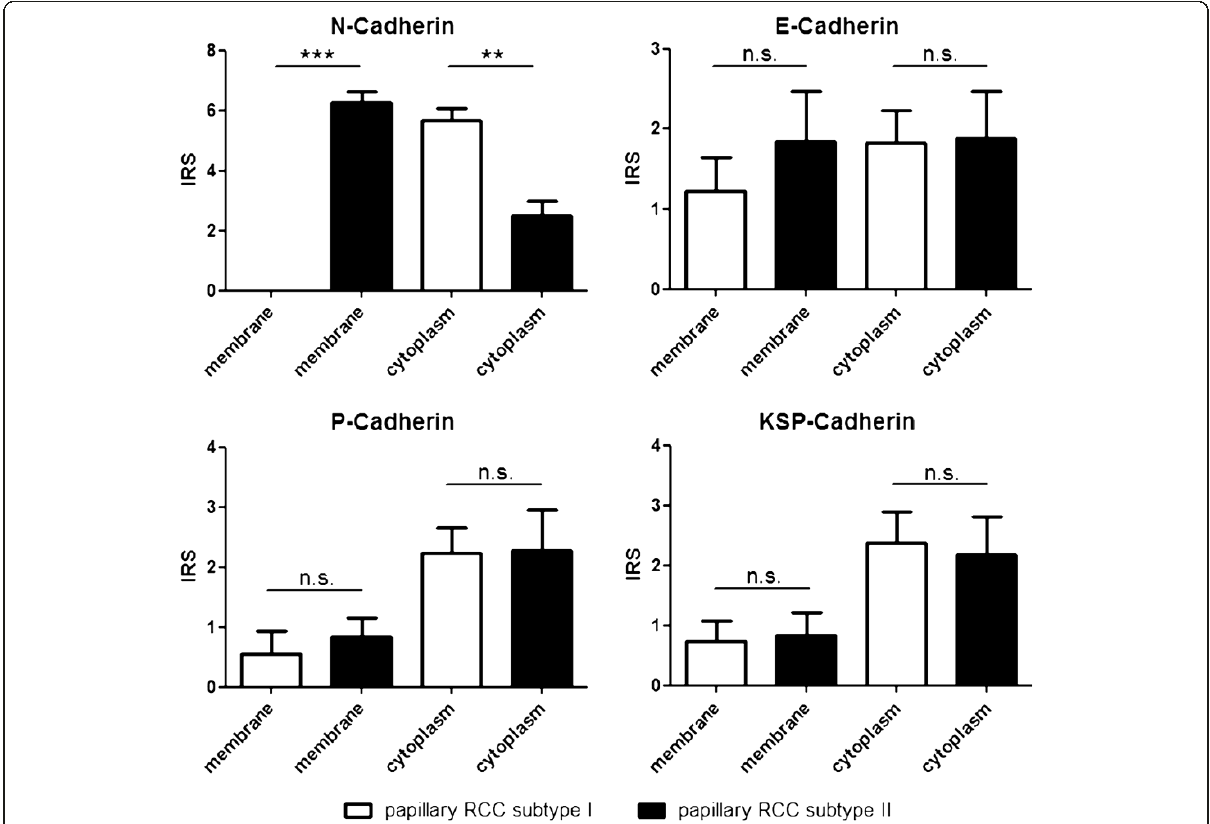
Figure 3 Immunohistochemistry of E-, P-, KSP- and cadherin expression in papillary RCC. Expression of E- ( A / D ), P- ( B / E ) and KSP- cadherin ( C / F ) in papillary RCC type II ( A , B , C x20) and type I ( D , E , F x20). The expression patterns are not suitable for a clear cut differentiation of both tumor subtypes (for details see